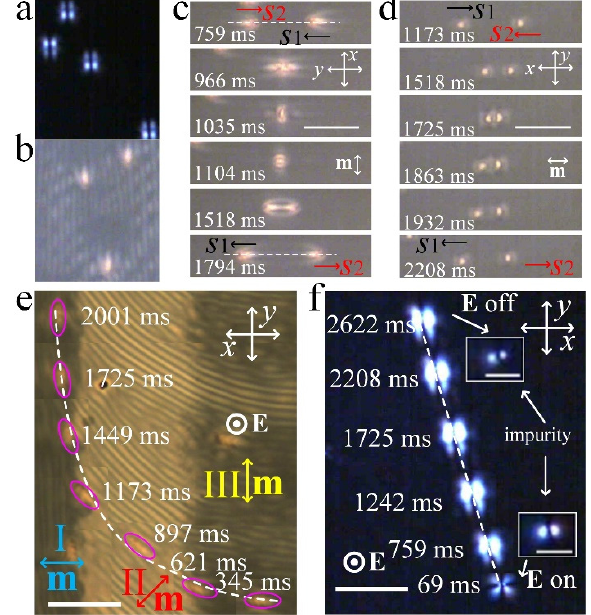
Figure 10. Dissipative solitons in chiral nematics. Solitons in achiral ( a ) and chiral ( b ) nematics. ( c ) Two solitons pass through each other. ( d ) Two solitons collide and reflect into opposite directions. ( e ) Motion of solitons in a cell divided into three regions with different alignment directions. ( f ) Micro-cargo transport by a soliton. Reprinted with permission from Ref. [102]. Copyright 2020 Nature.